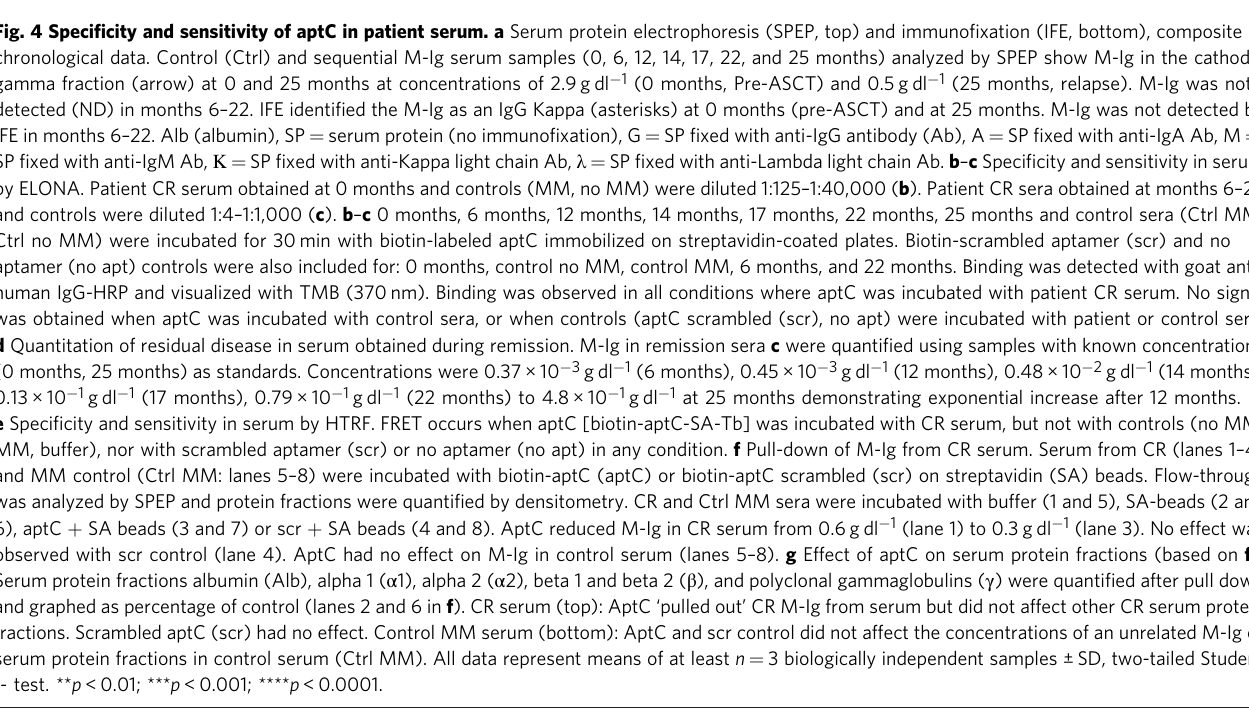
Fig. 4 Speci fi city and sensitivity of aptC in patient serum. a Serum protein electrophoresis (SPEP, top) and immuno fi xation (IFE, bottom), composite of chronological data. Control (Ctrl) and sequential M-Ig serum samples (0, 6, 12, 14, 17, 22, and 25 months) analyzed by SPEP show M-Ig in the cathodal gamma fraction (arrow) at 0 and 25 months at concentrations of 2.9 g dl − 1 (0 months, Pre-ASCT) and 0.5 g dl − 1 (25 months, relapse). M-Ig was not detected (ND) in months 6 – 22. IFE identi fi ed the M-Ig as an IgG Kappa (asterisks) at 0 months (pre-ASCT) and at 25 months. M-Ig was not detected by IFE in months 6 – 22. Alb (albumin), SP = serum protein (no immuno fi xation), G = SP fi xed with anti-IgG antibody (Ab), A = SP fi xed with anti-IgA Ab, M = SP fi xed with anti-IgM Ab, Κ = SP fi xed with anti-Kappa light chain Ab, λ = SP fi xed with anti-Lambda light chain Ab. b – c Speci fi city and sensitivity in